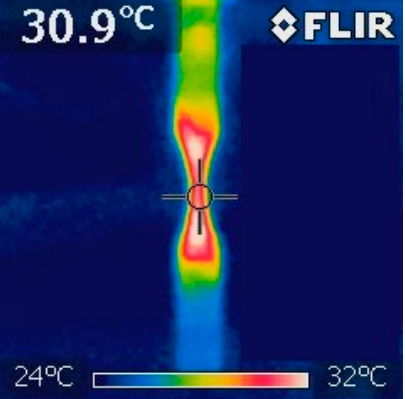
Figure 20. Temperature recorded by thermographic camera, during ultrasonic fatigue test.